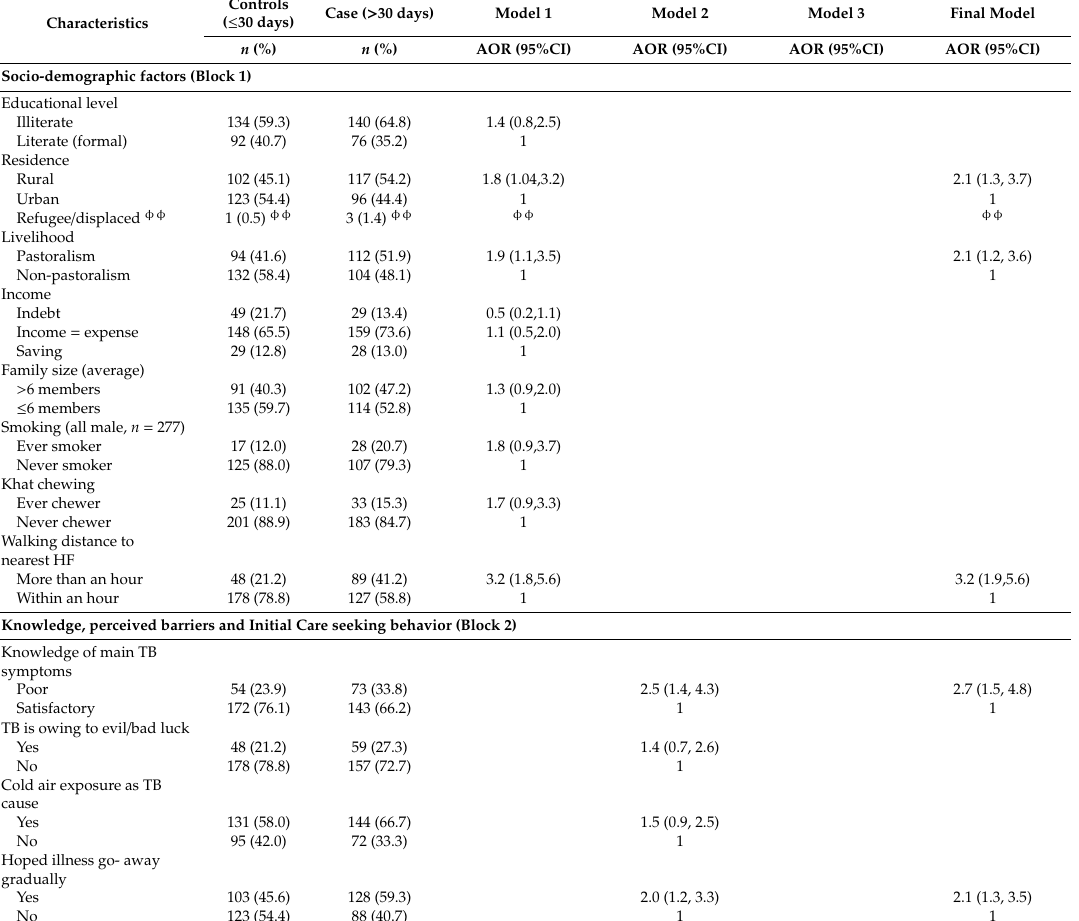
Table 2. Patient delay > 30 days among pulmonary TB patients in Somali Region, Ethiopia, December 2017 to October 2018, Hierarchical Analysis ( control = 226, cases =